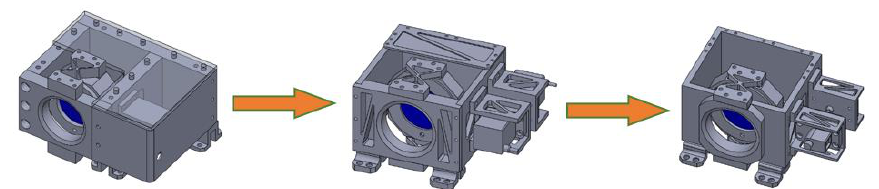
Figure 3. Development of the model of swing micro-mirror structure.